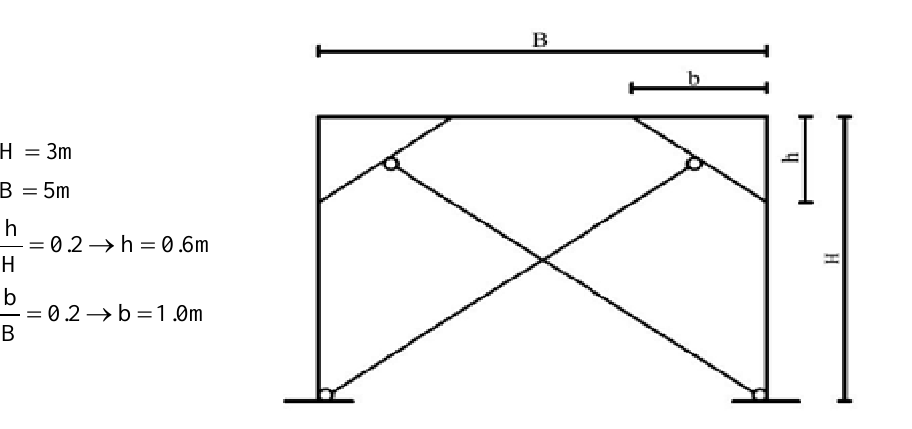
Fig. 3. The shape and dimension of KB.